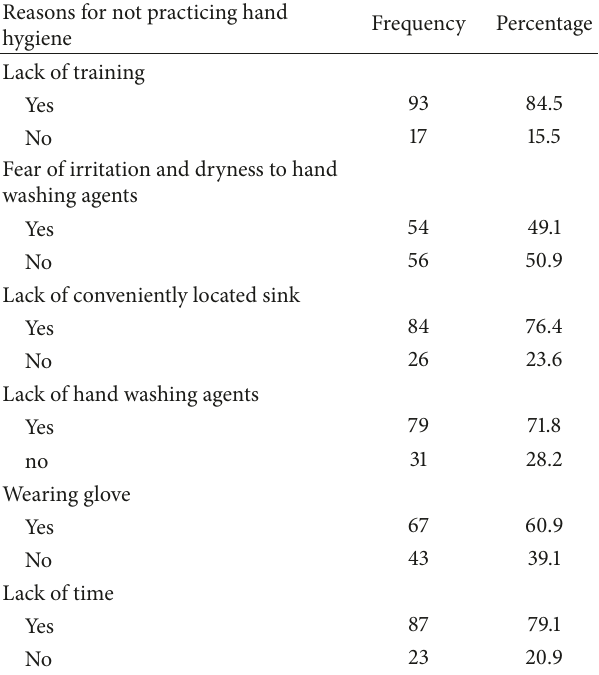
Table 3: Respondents’ reasons for not practicing hand hygiene in Hiwot Fana Specialized University Hospital [HFSUH], Harari, Eastern Ethiopia,